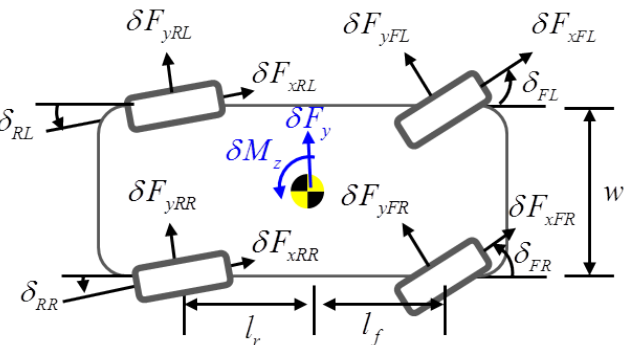
Figure 2. Tire forces generated from 4WD and 4WS actuators.